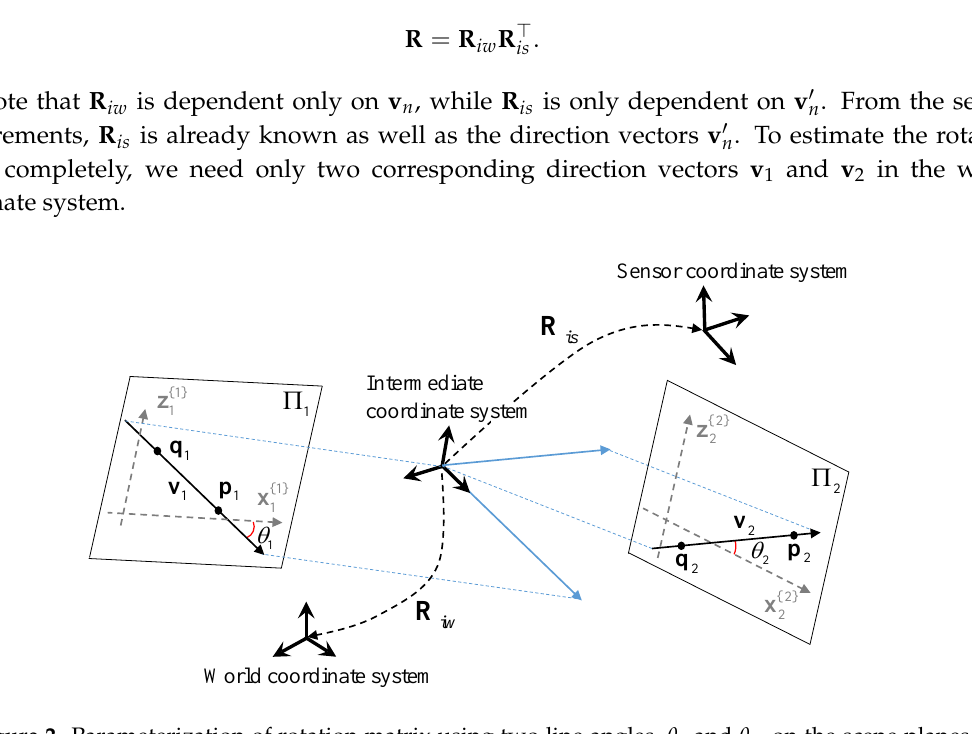
Figure 2. Parameterization of rotation matrix using two line angles, θ 1 and θ 2 , on the scene planes. The sensor-to-world rotation matrix R is expressed as two rotation matrices R iw and R is . The rotation matrix R iw is only dependent on θ 1 and θ 2 . From the sensor measurement, R is is already known as well as the direction vector v (cid:48) and v (cid:48) 2 1